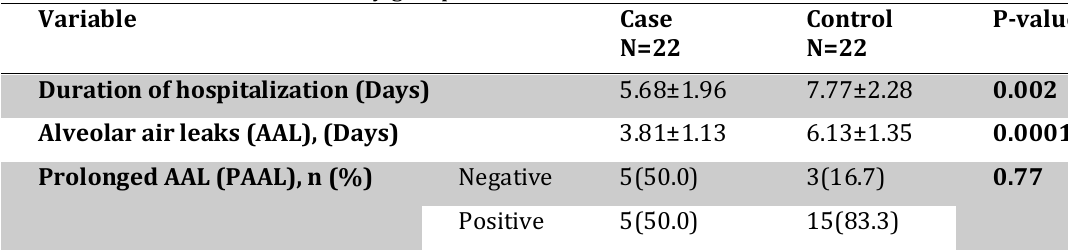
Table 3: Clinical outcomes in 2 study